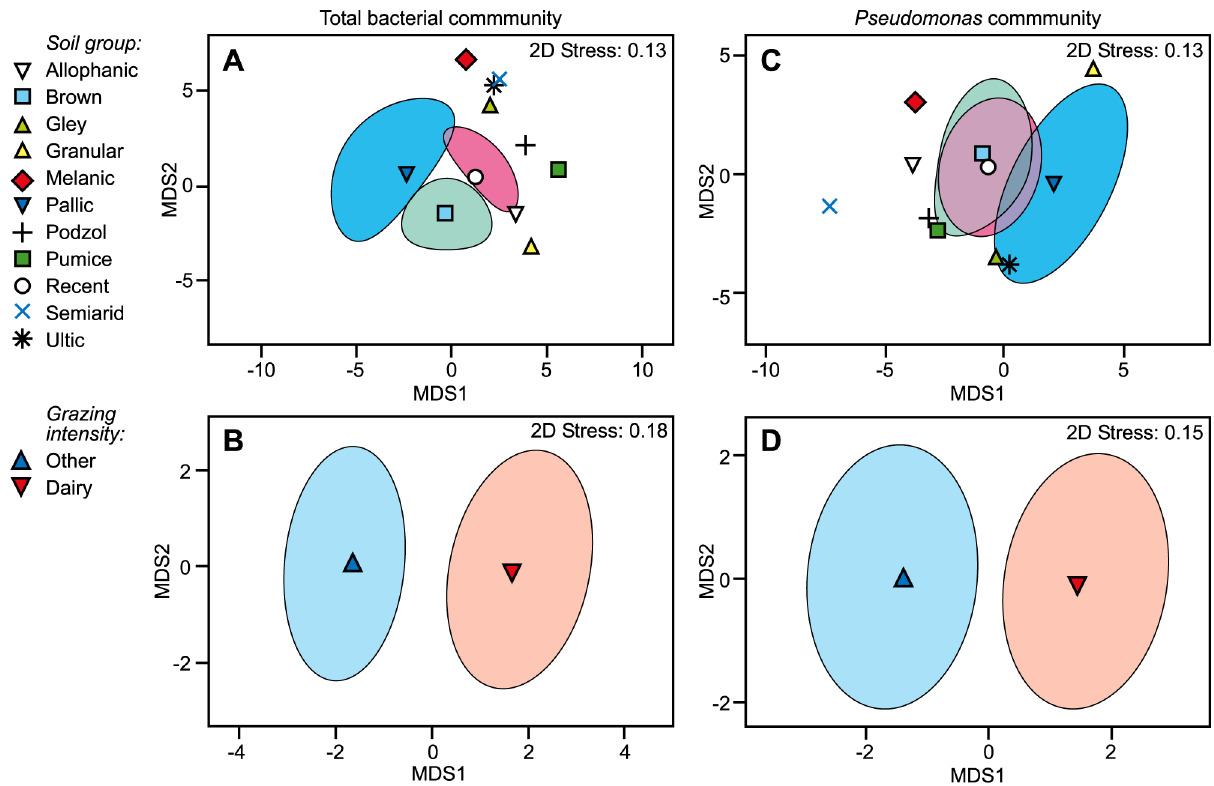
Fig 1. Influence of soil type and land use on microbial community structure: metric MDS ordination plots of mean total bacterial (A and B) and Pseudomonas (C and D) communities. The structures of the total bacterial and Pseudomonas communities were assessed based on the relative abundance of terminal restriction fragments (TRFs) and denaturing gradient gel electrophoresis (DGGE) banding patterns, respectively. Mean communities (individual points) for each land use and soil type were derived from 150 bootstrap averages. For land uses and soil types with sufficient replication, 95% region estimates for the mean communities (clouds) represent the spread of the bootstrap averages. Points and/or 95% region estimates in closer proximity represent groups that share increasing similarity in microbial community structure. Observations are statistically supported by PERMANOVA testing of Bray-Curtis dissimilarity data (S4 Table). Underlying OTU data for T-RFLP and DGGE analysis is available in S5 and S6 Tables,